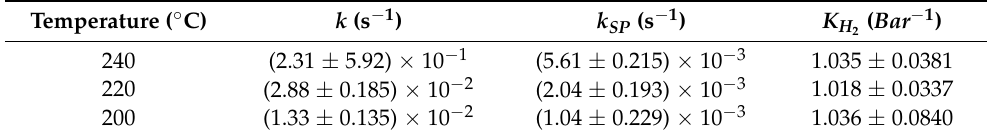
Table 8. Estimated kinetic parameters and their uncertainty for a 97.5% confidence interval for Model